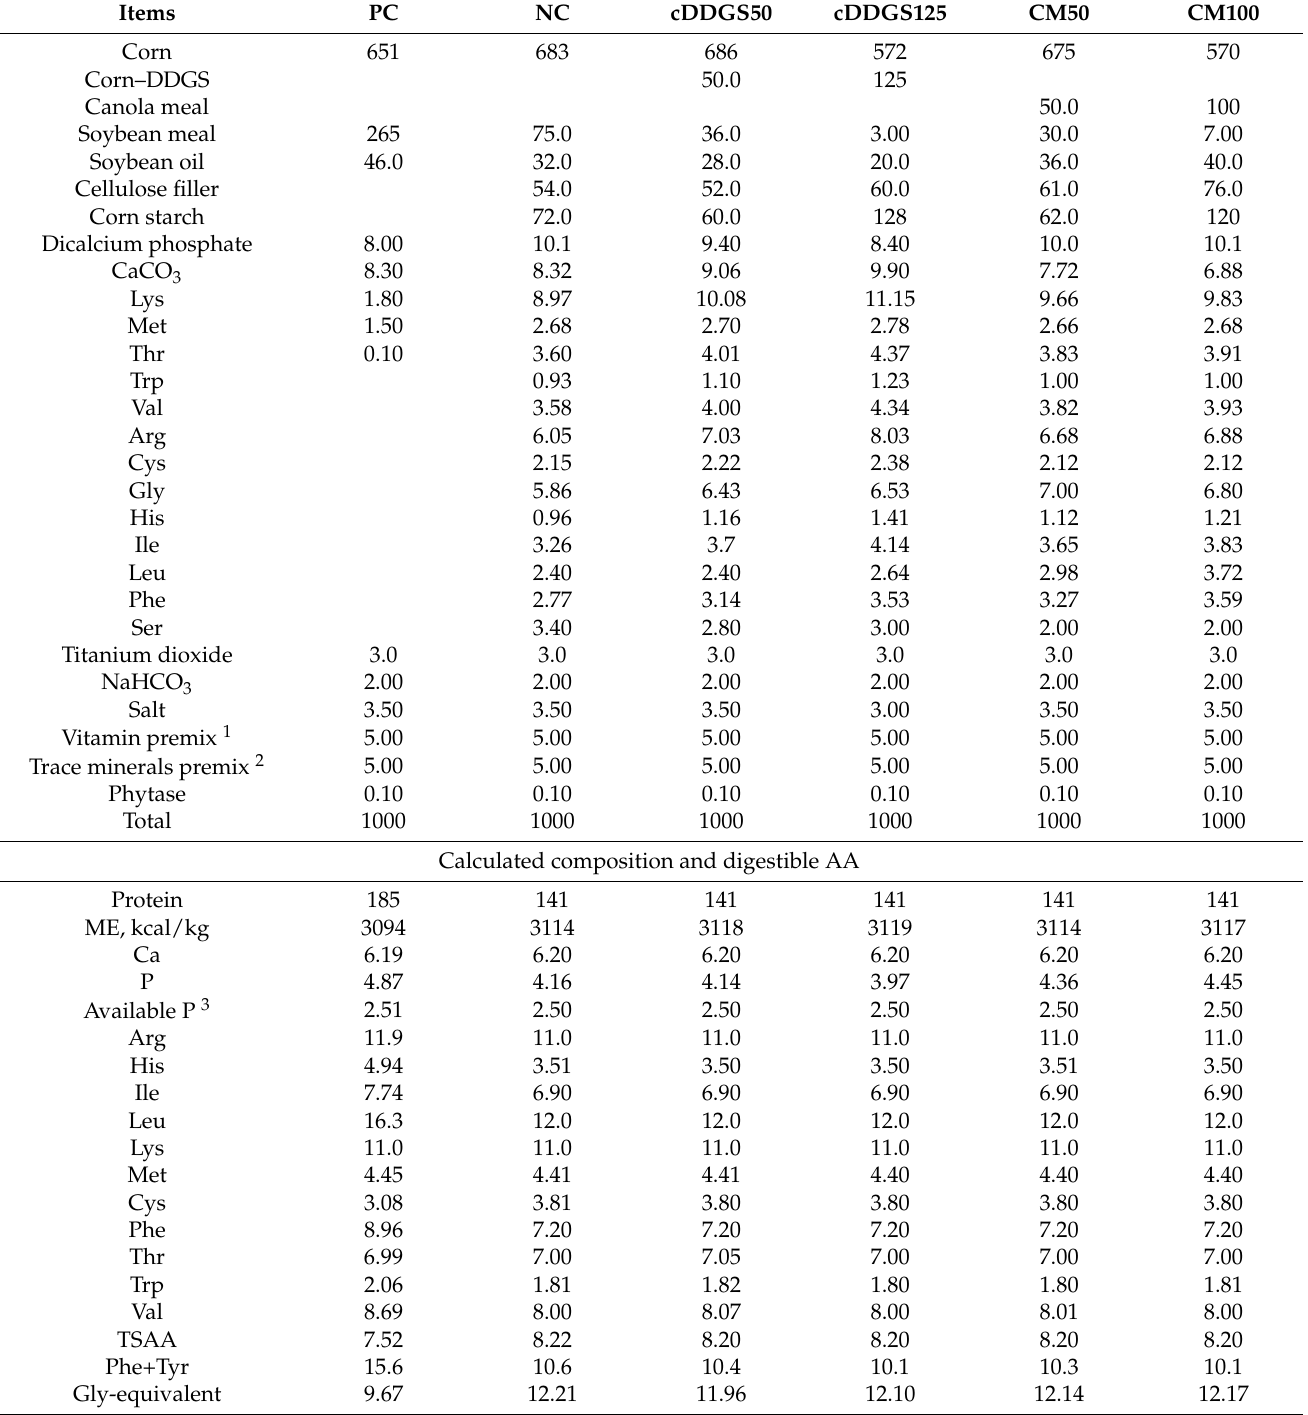
Table 3. Feedstuffs and chemical compositions (g/kg) of grower phase diets (d 10 to 28) fed to broilers receiving diets containing soybean meal with reduction in crude protein or low-protein diets with serial inclusion levels of canola meal or corn–DDGS supplemented with crystalline amino